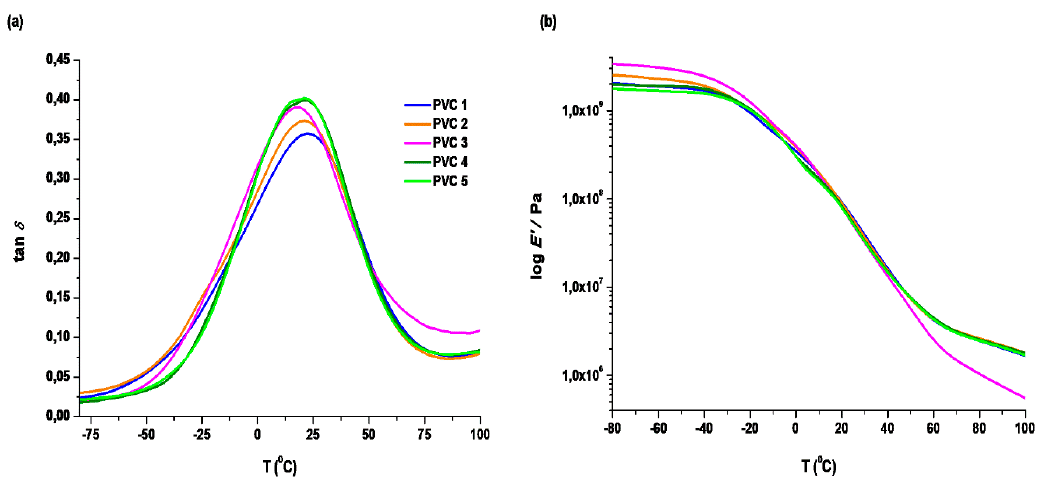
δ and ( b ) E (cid:48) traces of all plasticized PVC